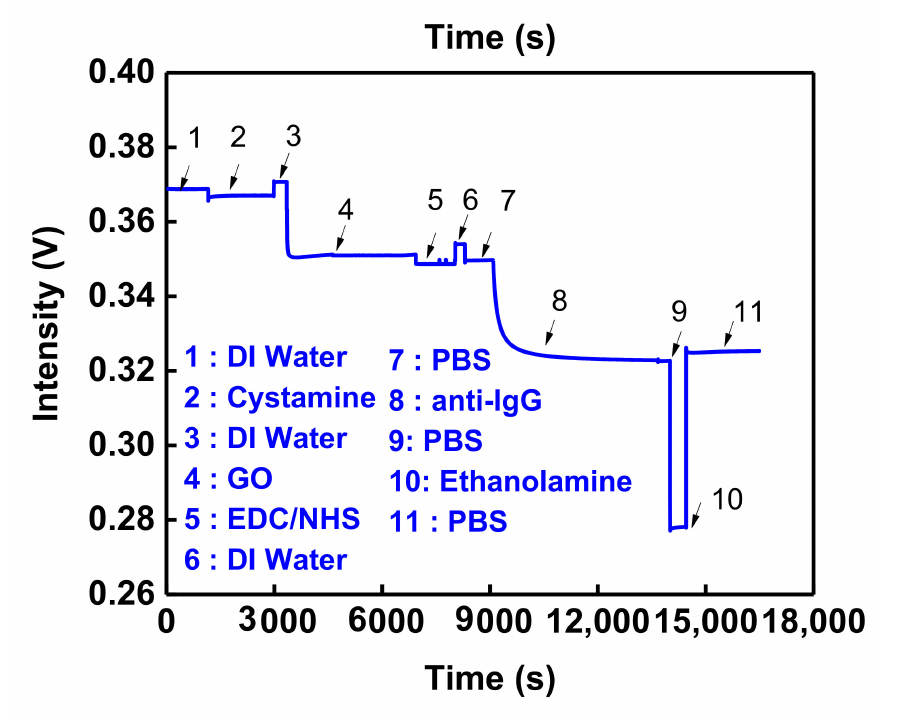
Figure 6. Real-time functionalization of AuNP-Cys-GO-anti-IgG chip.